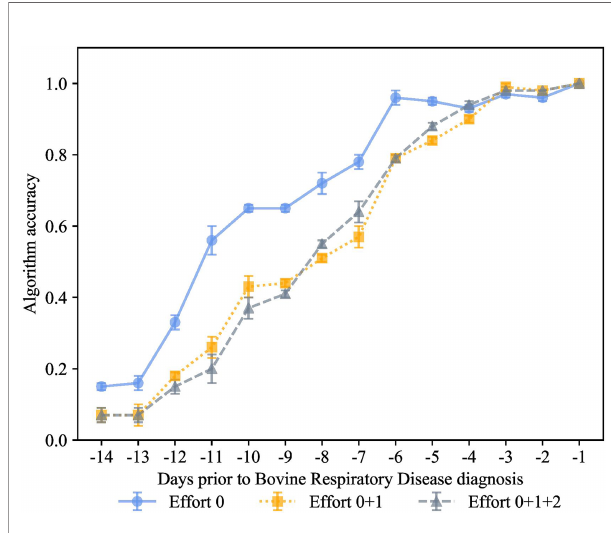
FIGURE 6 | K-nearest neighbor ’ s algorithm accuracy (mean ± SD) with 75% of training and 25% of testing from 10 runs of cross-validation for predicting calves destined for bovine respiratory disease diagnosis using automatically collected features by an automated milk feeder and accelerometer and manually collected features using outward clinical signs of bovine respiratory disease in a 106 dairy calf cohort.